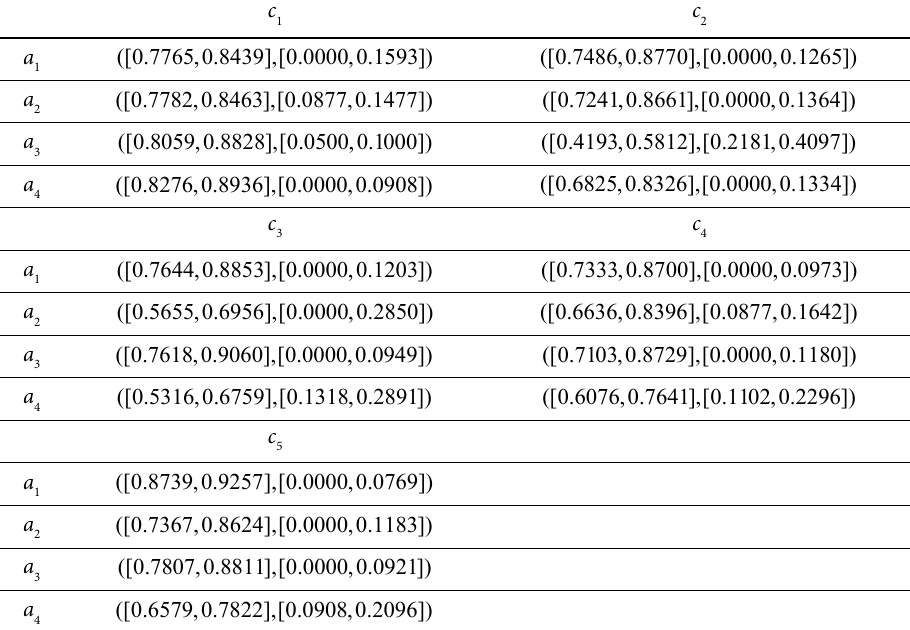
Table 8. Collective interval-valued intuitionistic fuzzy decision matrix of